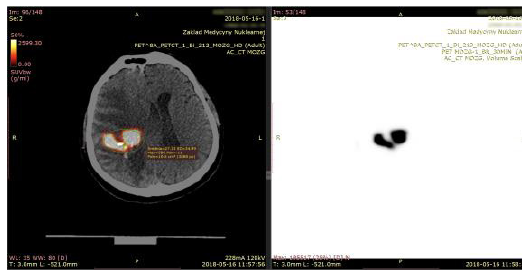
Fig. 1. The fusion of PET images with coupled CT images is one of the most accurate diagnostic methods allowing to localize pathological changes from 3 mm in